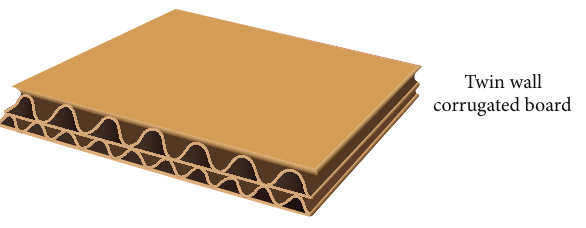
Figure 1: Twin corrugated wall board structure.